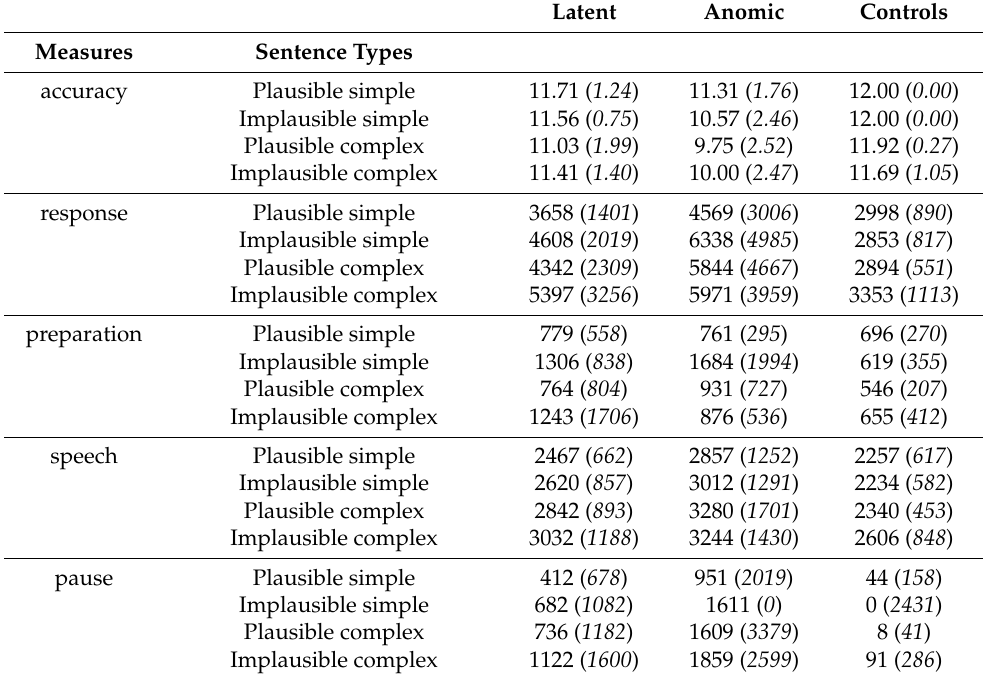
Table 2. Descriptive statistics (accuracy, temporal speech